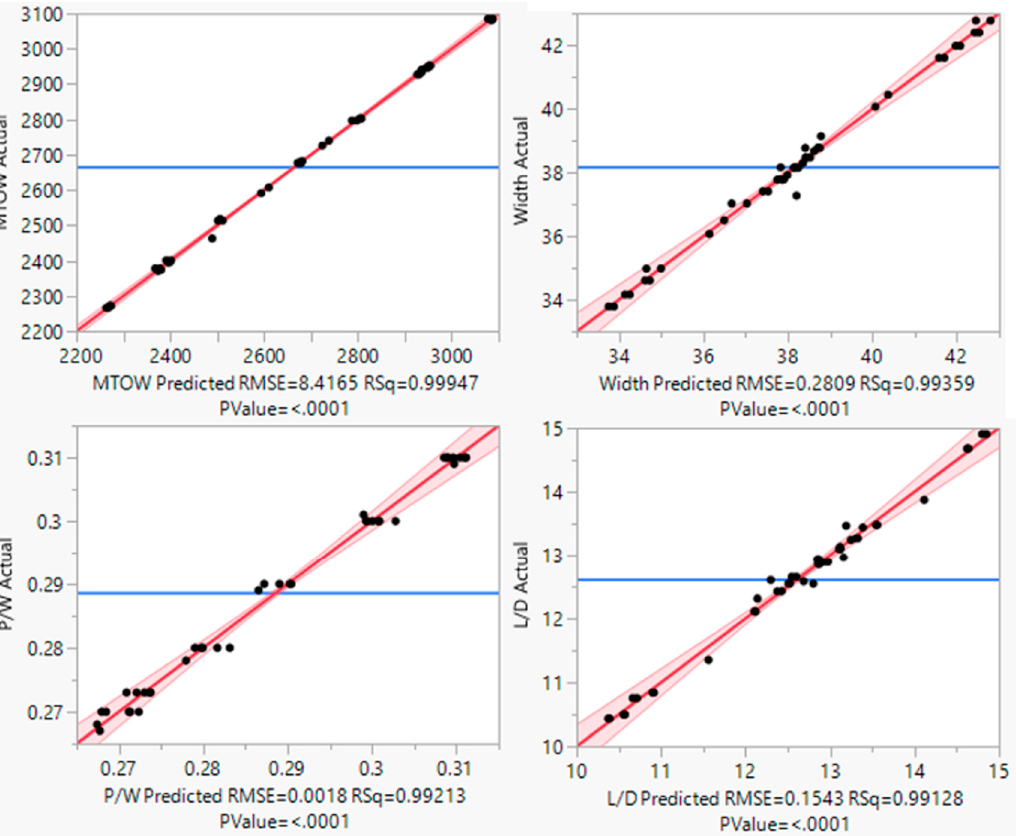
Figure 14. Response surface method graph.